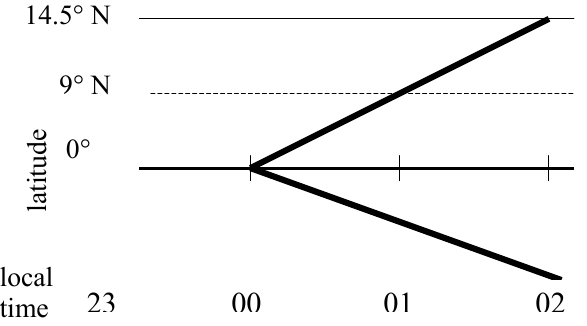
Fig. 2. Lateral V structure of the midnight pressure bulge adopted here. Dark lines represent ridge of high pressure shown crossing the dip equator at 9 ◦ N and the 14.5 ◦ N latitude, from which ions are driven downward to the maximum at 16 ◦ N. Southern arm is mirror image of northern